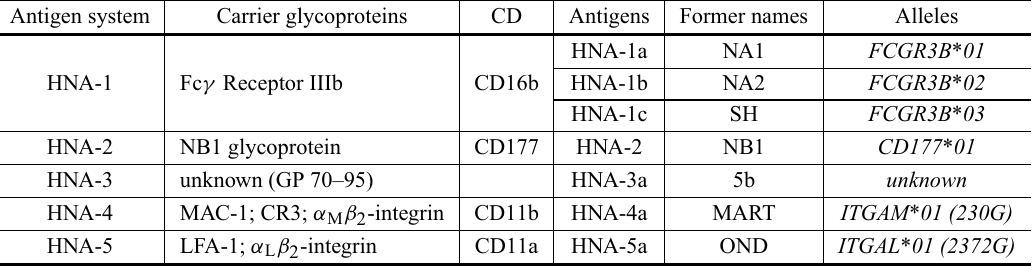
ISBT Human neutrophil alloantigens (HNA)